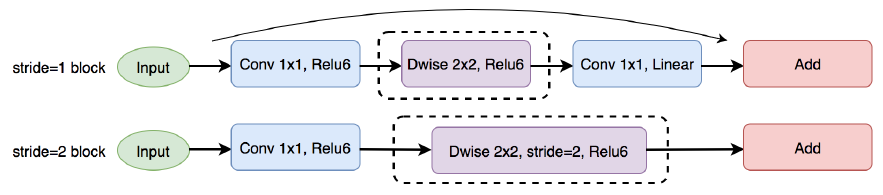
Figure 11. Model 2: Architecture of proposed network 2 for object detection.